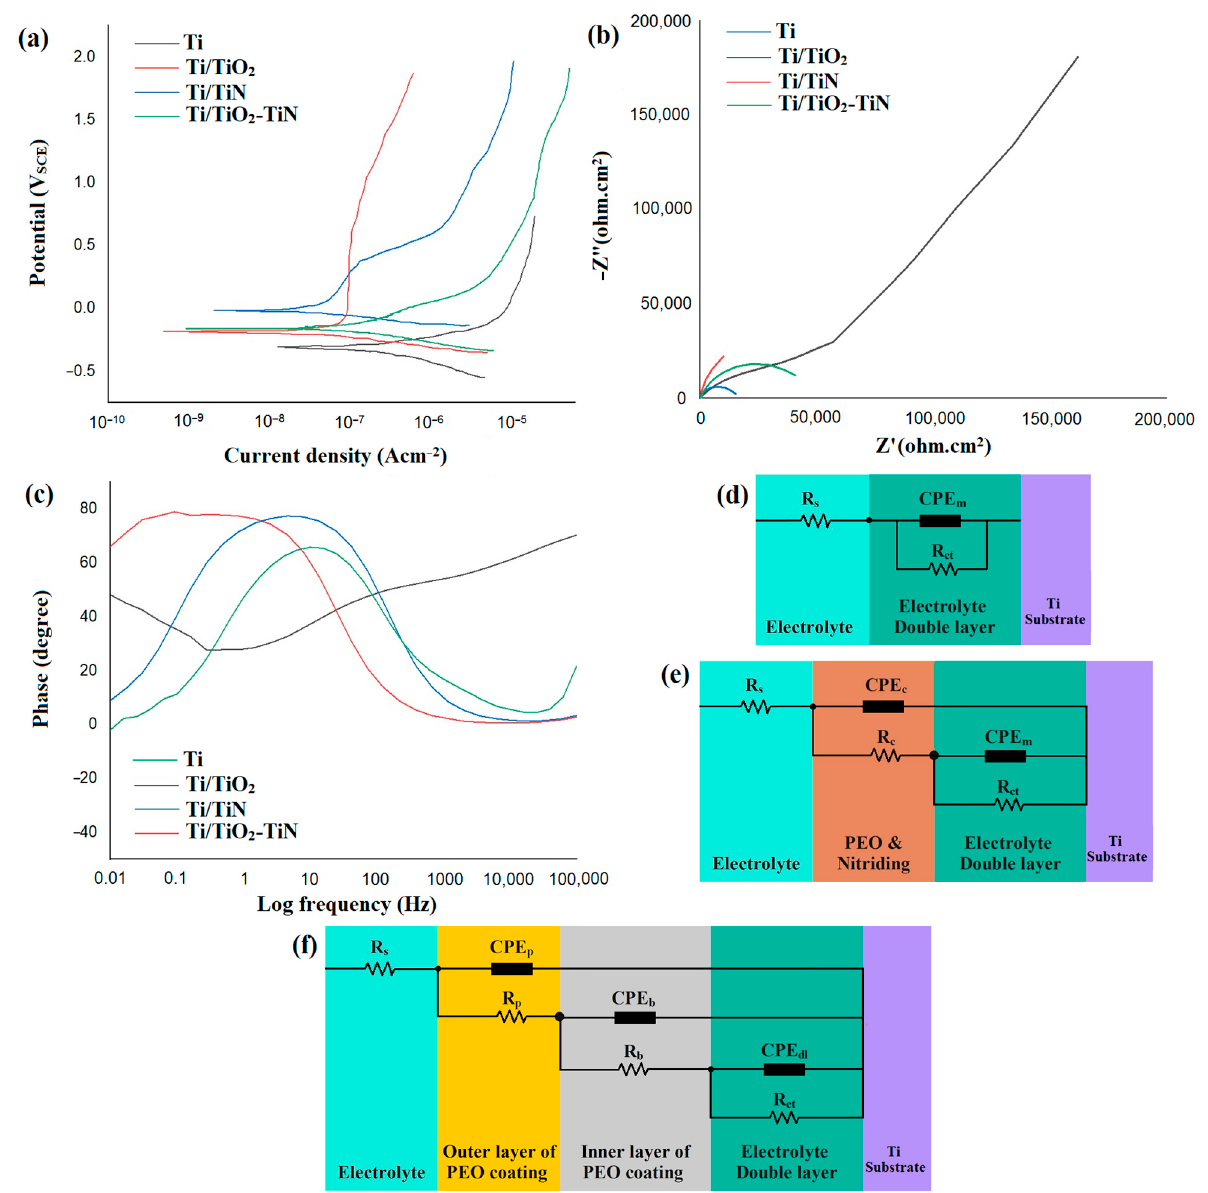
Figure 8. ( a ) Potentiodynamic polarization curves. ( b ) Nyquist and ( c ) Bode phase diagrams and proposed equivalent circuit for EIS results of bare and coated samples; ( d ) Ti and Ti/TiN; ( e ) Ti/TiO 2 -N; and ( f ) Ti/TiO 2.